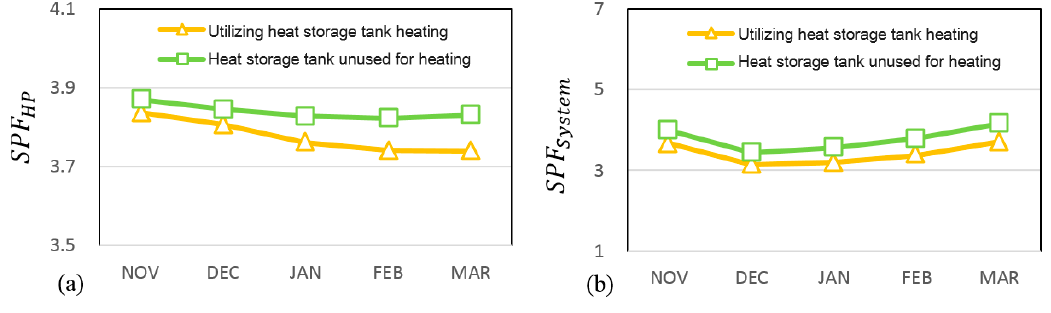
Figure 30. The SPF considering storage tank heating during 24 h operation. ( a ) Heat pump; ( b ) total system.